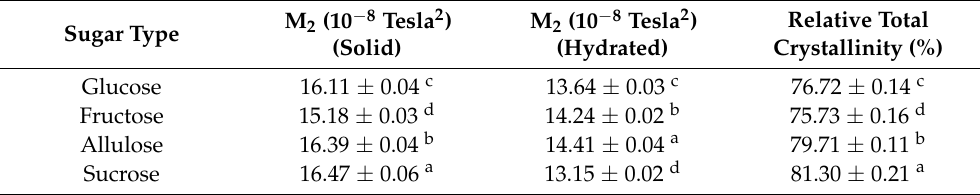
Table 3. Second Moment (M 2 ) results by MSE sequence and Relative Total Crystallinity (%) of sugars measured by